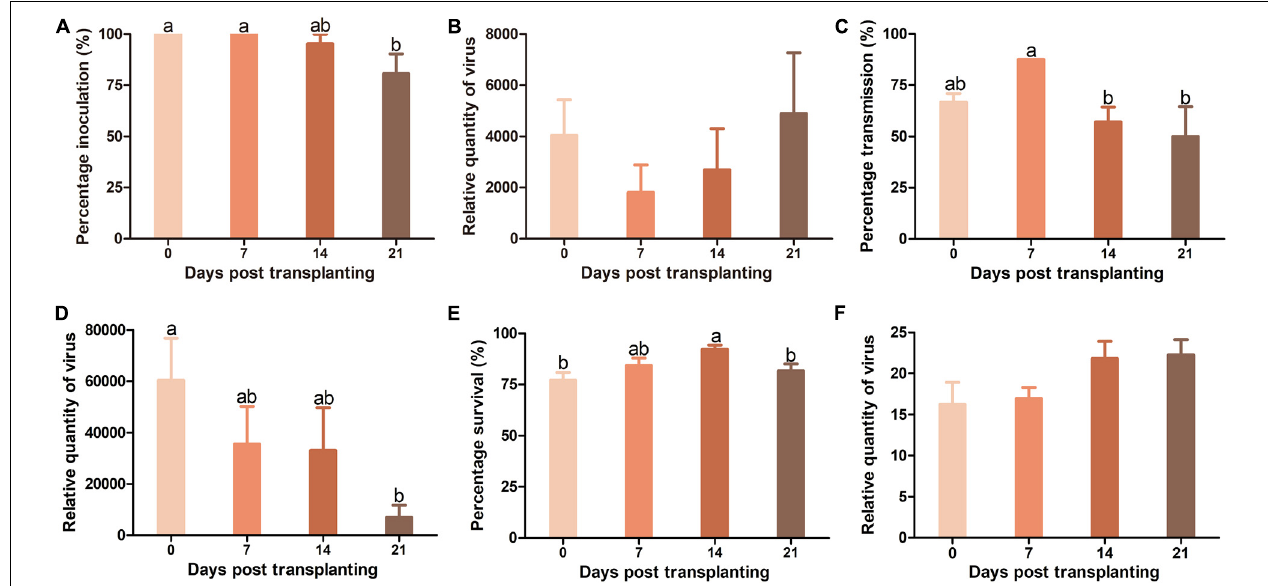
FIGURE 4 | Resistance to tomato yellow leaf curl virus (TYLCV) in Pufen5 seedlings of 0, 7, 14, and 21 DPT. (A) Percentage of TYLCV-infected plants in agro-inoculated plants; (B) Relative quantity of virus in agro-inoculated plants; (C) Percentage of TYLCV-infected plants in whitefly-inoculated plants; (D) Relative quantity of virus in whitefly-inoculated plants; (E) Whitefly survival on tomato seedlings of different ages; (F) Relative quantity of virus in whiteflies recovered post virus transmission. Values are means ± SEM [ n = 3 and in each replicate 7–8 plants were used for panels (A,C) ; n = 7–8 for panels (B,D) ; n = 21–24 for panel (E) ; n = 4 for panel (F) ]. Different letters above the columns indicate significant differences (one-way ANOVA, p < 0.05).